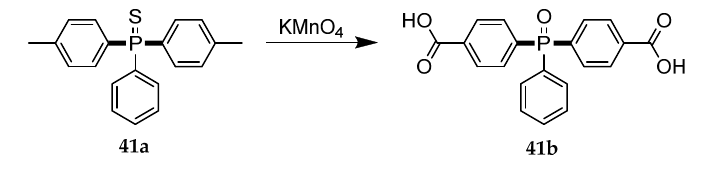
Scheme 5. Oxidation of 41a to 41b